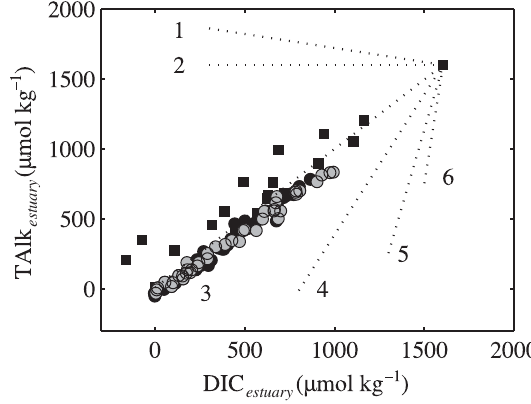
Figure 6. (a) Covariation of DIC estuary and TAlk estuary . Black squares are samples from the Shark River during SharkTREx 1, and black and gray circles are from the Shark and Harney rivers, re- spectively, during SharkTREx 2. Dotted lines represent the theoret- ical covariation of DIC and TAlk for different biogeochemical pro- cesses: (1) aerobic respiration; (2) CO 2 emission, (3) sulfate reduc- tion, (4) CaCO 3 dissolution, (5) manganese reduction, and (6) iron